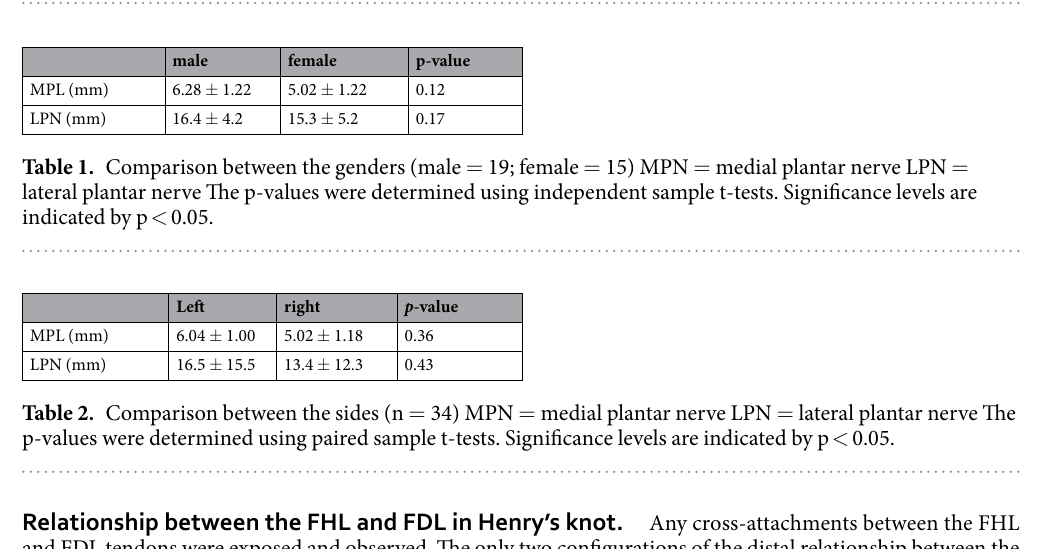
Figure 3. No distance between the medial plantar nerve and Henry’s knot in Pattern 2 (1). FHL, (2). FDL, (3). medial plantar nerve, (4). lateral plantar nerve, (5). medial plantar artery, (6). lateral plantar artery, (7). Henry’s knot, (8). posterior tibial artery, (9). tibial nerve, (10). artery.